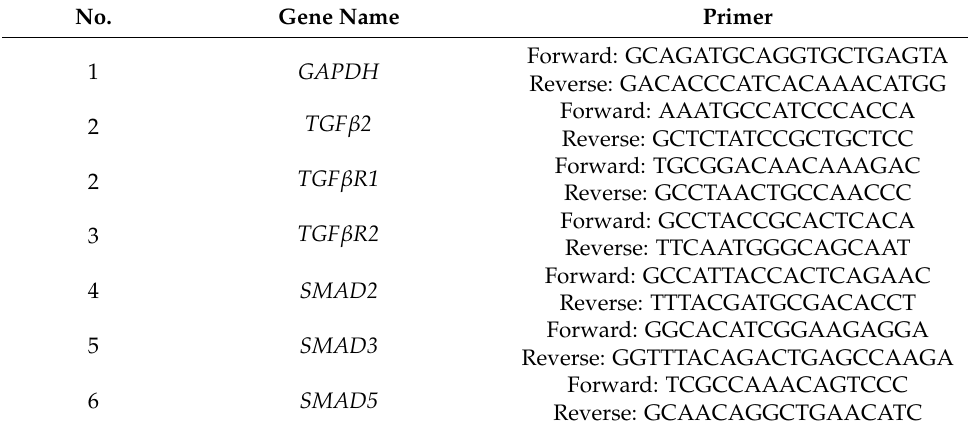
Table 2. GAPDH was amplified as an endogenous control. Table 2. The primer of all genes which in present